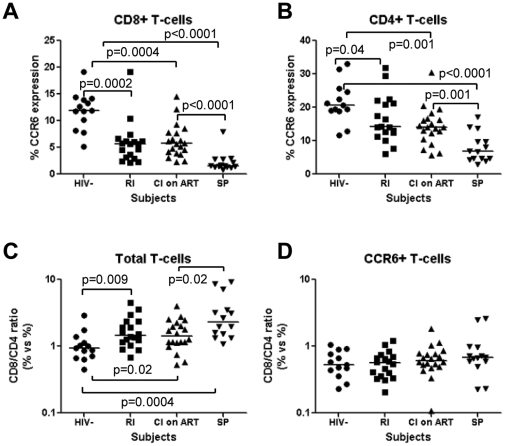
The frequency of CD8+ and CD4+ T-cells expressing CCR6 is decreased in HIV infected subjects with slow and rapid disease progression.Peripheral blood mononuclear cells (PBMC) from HIV-uninfected (HIV-; n = 13) and HIV+ subjects recently infected untreated (RI, n = 18), chronically infected under long-term viral suppressive antiretroviral therapy (CI on ART; n = 20), and slow progressors (SP, n = 14) were stained with a cocktail of fluorescence-conjugated CD3, CD4, and CCR6 Abs. The frequency of (A) CD3+CD4− T-cells (referred to as CD8+ T-cells) and (B) CD3+CD4+ T-cells (referred to as CD4+ T-cells) expressing CCR6 was quantified by polychromatic flow cytometry and compared between HIV-uninfected controls and RI, CI on ART, and SP HIV-infected subjects. The CD8/CD4 T-cell ratios were calculated within the total (C) and CCR6+ T-cell fractions (D) in the group of HIV-uninfected controls and the three groups of HIV-infected subjects. Horizontal bars indicate median values. Mann-Whitney p-values are indicated in the figures.